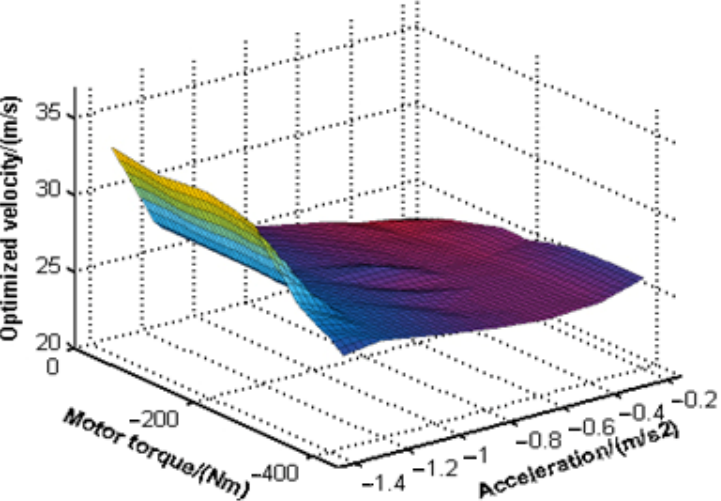
Figure 14. Optimization of vehicle velocity in gears 5 to 4.